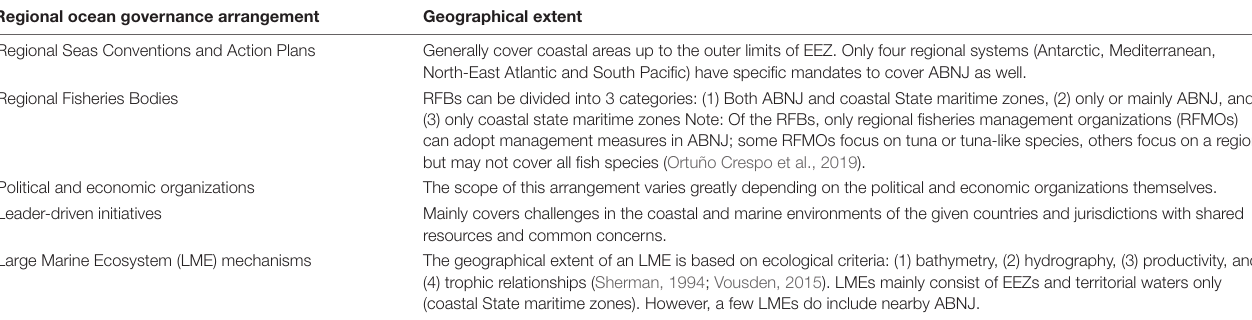
TABLE 2 | Geographical extent of regional ocean governance arrangements. Regional ocean governance arrangement Geographical